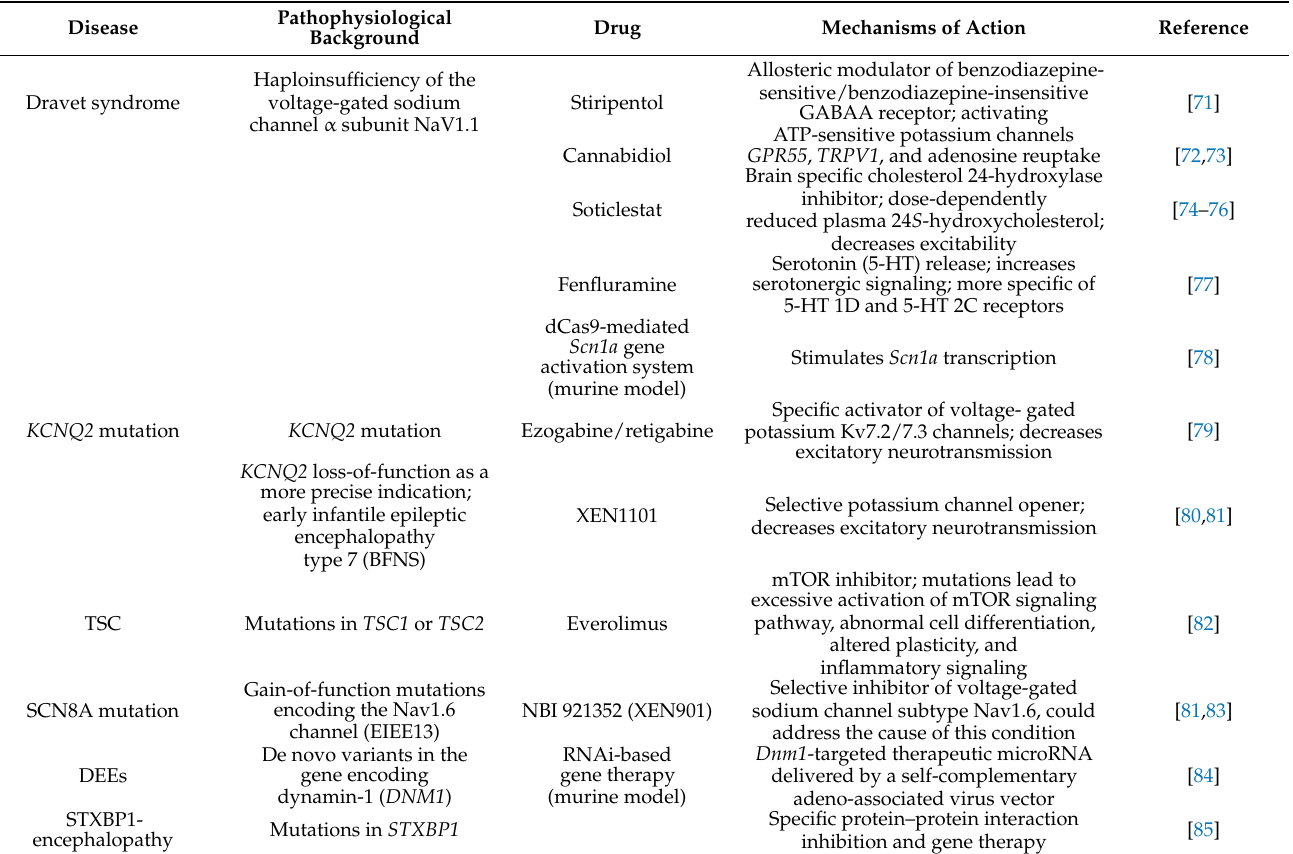
Table 2. Diseases and drugs as subjects of recent advances in patients with